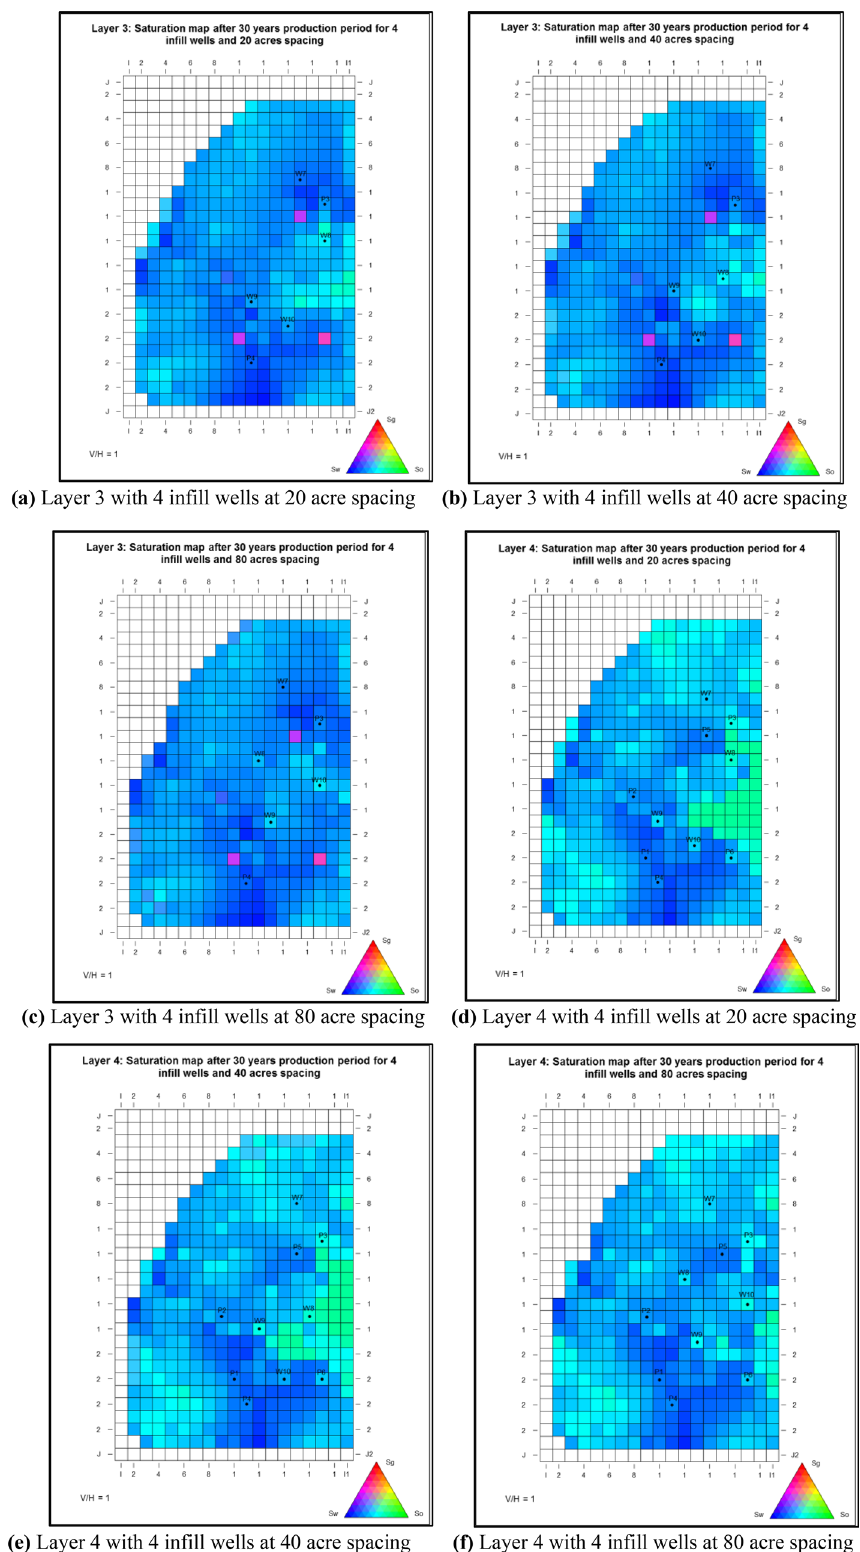
Fig. 17 Saturation distribution maps for layers of the reservoir with 4 infill wells located at dif- ferent well spacings (additional 15 years simulated production